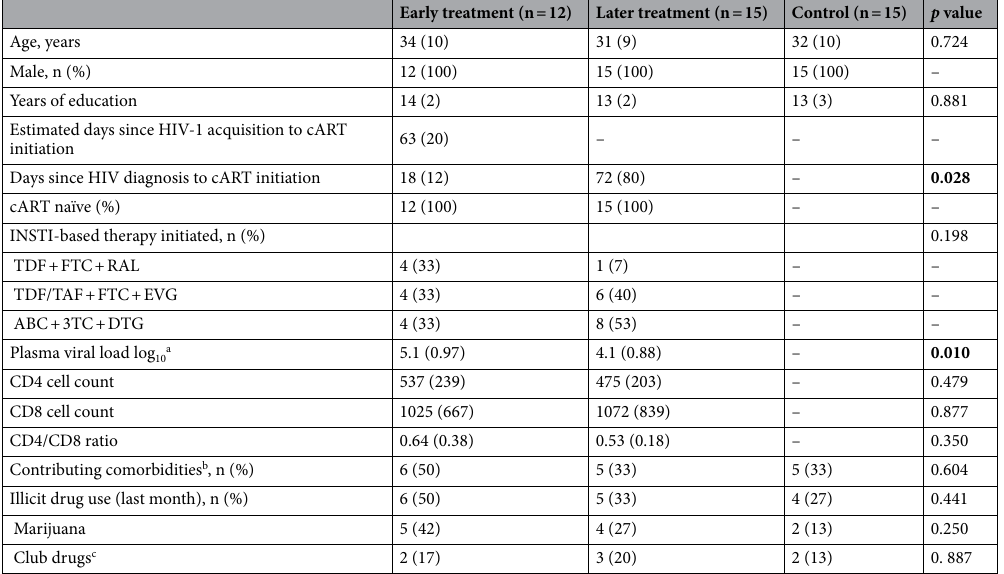
Table 1. Characteristics of the study sample. Values are expressed as mean (standard deviation) except when indicated otherwise. Continuous variables were compared using the ANOVA for means test. Categorical variables were compared using the chi-square test. Statistical significance was set at p < 0.05. Bold values denote statistical significance. Abbreviations: 3TC = lamivudine; ABC = abacavir; cART = combination antiretroviral therapy; DTG = dolutegravir; EVG = elvitegravir; FTC = emtricitabine; INSTI = integrase strand transfer inhibitor; TAF = tenofovir alafenamide fumarate; TDF = tenofovir disoproxil fumarate; RAL = raltegravir.